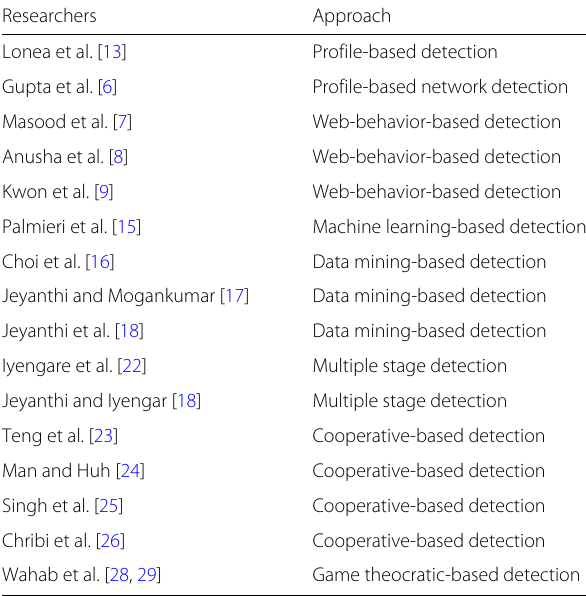
Table 3 Cloud-based detection approaches